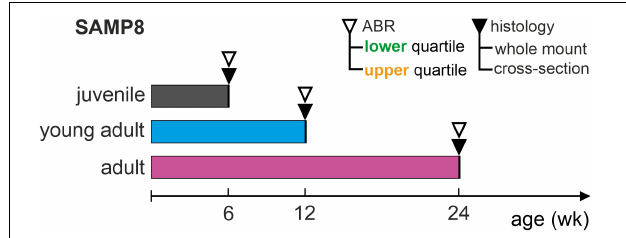
FIGURE 1 | Schematic representation of the experimental design. Auditory function over age was assessed in SAMP8 mice by determining auditory brainstem response (ABR) thresholds for each age group: juvenile (6 weeks), young adult (12 weeks), and adult (24 weeks). ABR thresholds were compared with respective reference distributions from accumulated controls for each age group (reference cohort), and then allocated to the lower (generally below the 25th percentile) or upper (generally above the 75th percentile) quartiles. Following this, mice in the lower or upper quartiles were sacrificed and their cochleae extracted for histology, using one cochlea for whole-mount and the other for cross-section analysis. This study included a total of 22 mice (out of 46